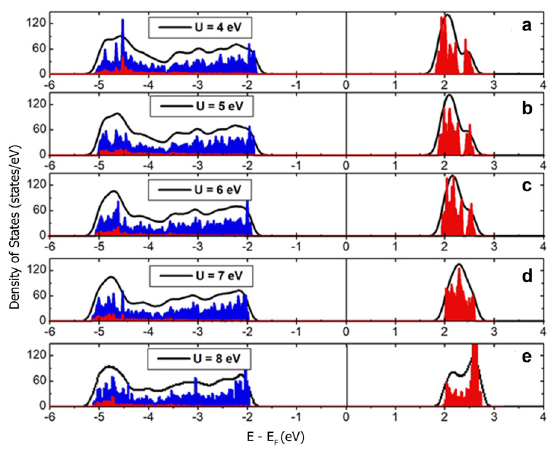
Fig. 4. The total and orbital projected densities of states (TDOS and PDOS) of LTO. The blueand red colors are the orbital projected density of states (PDOS) of O-2p and Ti-3d orbitals respectively. The vertical solid line corresponds to Fermi